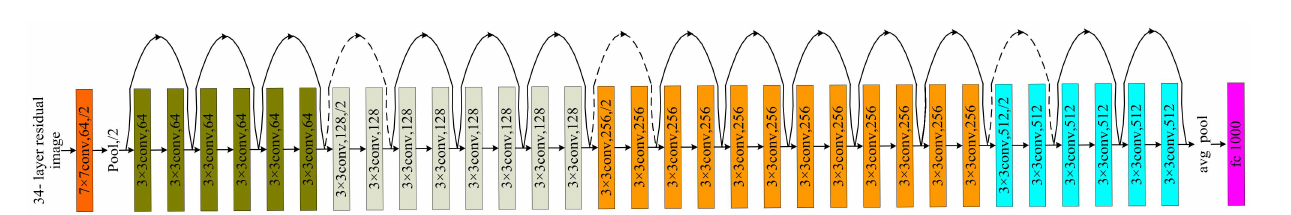
Figure 16. The structure of